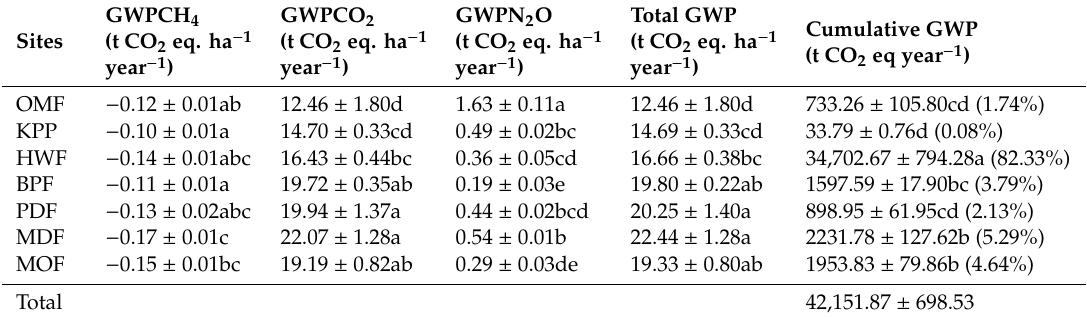
Table 5. Estimation of Global Warming Potential (GWP) for each forest type at the Maoershan Ecosystem Research Station in Northeast China. Data are expressed as mean ± SE, n =